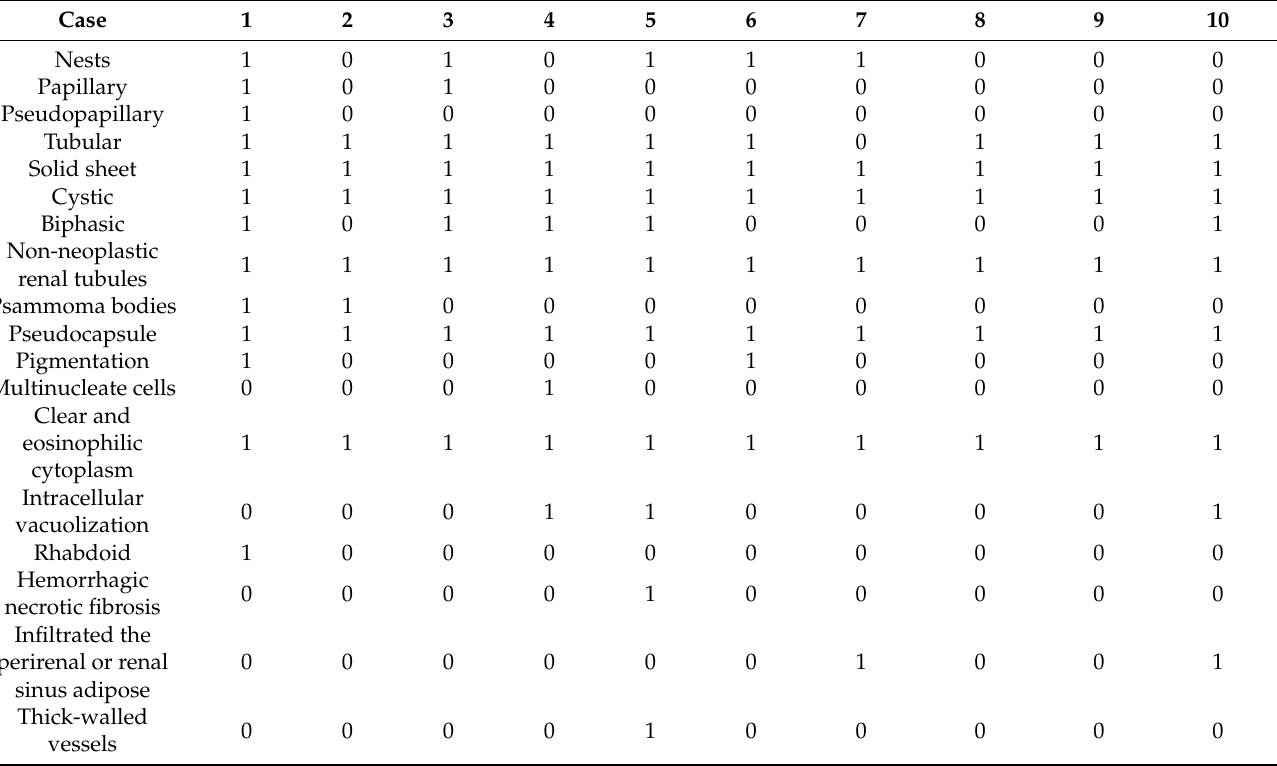
Table 2. The microscopic features of architecture and cell